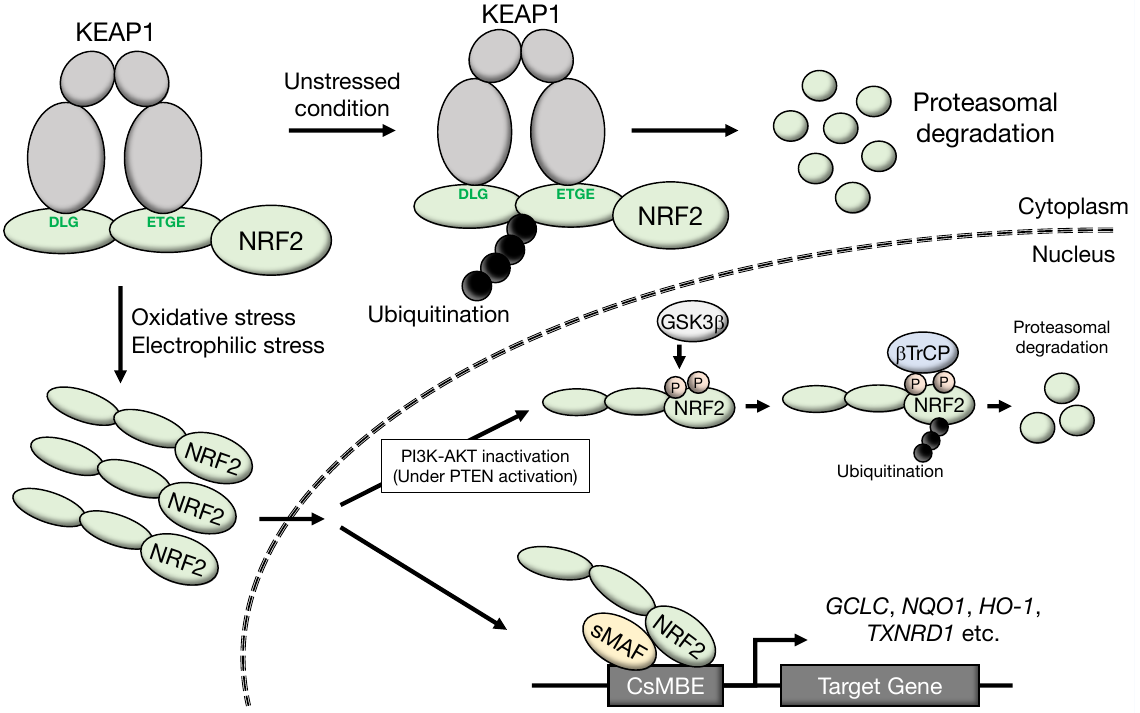
Figure 1. Molecular mechanisms of NRF2 activation: NRF2 degradation is accelerated through ubiquitination of NRF2 by the KEAP1-CUL3 complex and β TrCP-CUL1 complex. Under unstressed conditions, the KEAP1 homodimer binds NRF2 at two sites within the Neh2 domain, i.e., the DLG and ETGE motifs, and NRF2 is ubiquitinated efficiently. Because NRF2 is rapidly degraded by the proteasome system, the NRF2 protein is maintained at a very low level in unstressed conditions. Upon exposure to oxidative or electrophilic stresses, specific reactive cysteine residues within KEAP1 are modified. This modification attenuates the ubiquitin ligase activity of KEAP1. Thus, NRF2 is stabi- lized, translocates into the nucleus, and activates a set of cytoprotective genes. On the other hand, the β TrCP-CUL1 complex also ubiquitinates NRF2. To be recognized by β TrCP, NRF2 is phosphorylated by GSK3 β at two specific serine residues in the Neh6 domain. Phosphorylated NRF2 is ubiquitinated by the β TrCP-CUL1 ubiquitin E3 ligase complex and degraded through the proteasome system. A cascade of signal transduction has been clarified in which GSK3 β is inhibited/phosphorylated by the activated PI3K-AKT pathway, which is under the negative regulation of PTEN. CsMBE, CNC-sMAF binding element.